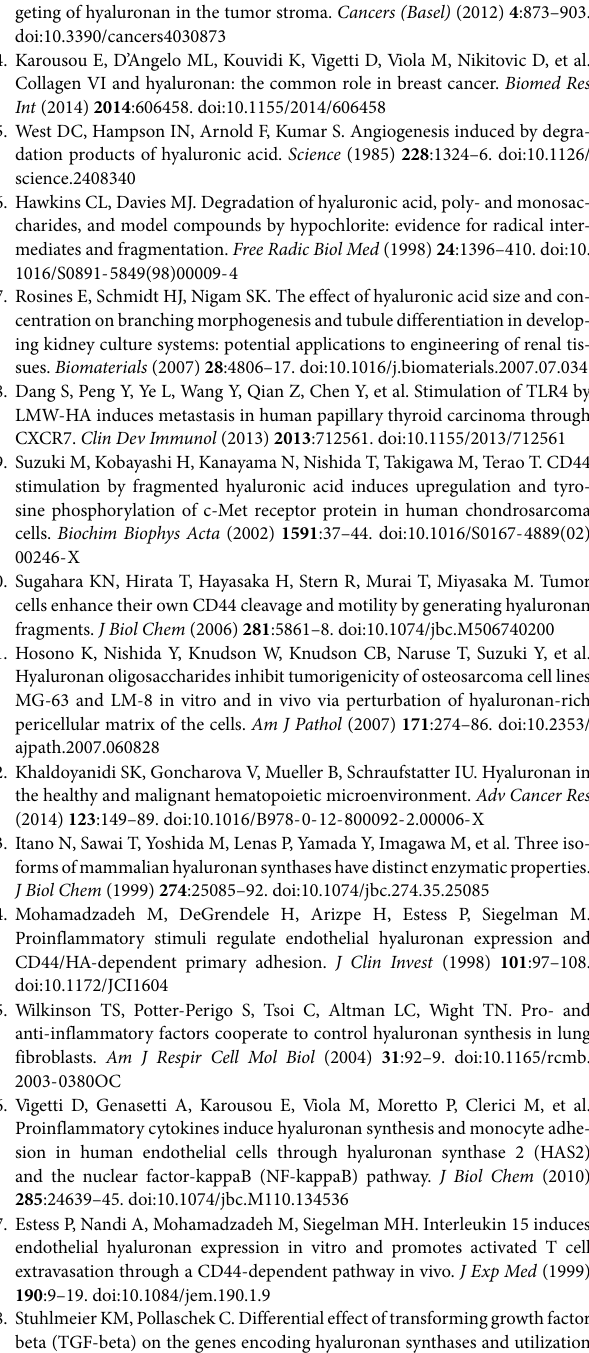
Table S1 | HA size in tissue in vivo . HA molecular weight (MW) is divided into High (HMW >1000kDa), Medium (MMW 250–1000kDa), Low (10–250kDa), and Oligo-HA